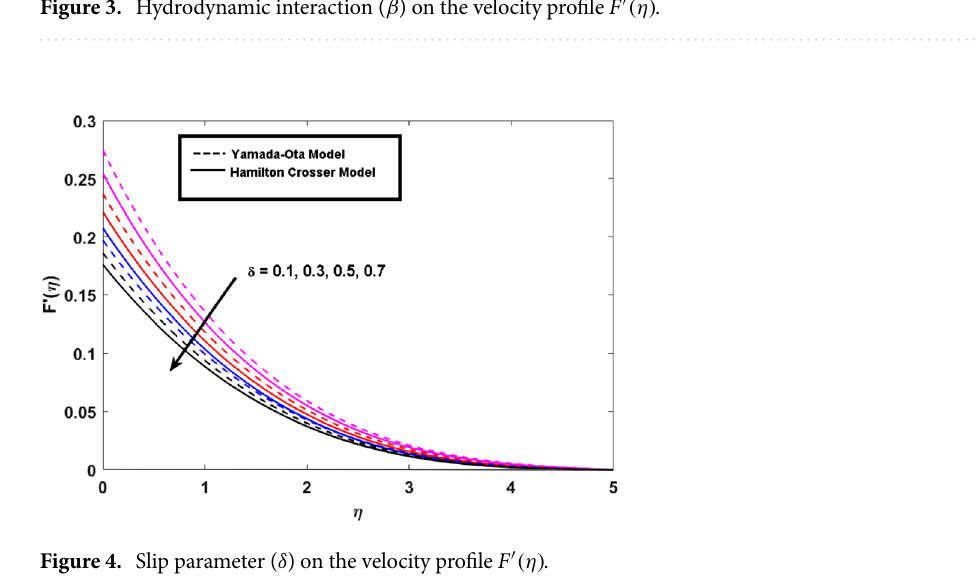
Figure 3. Hydrodynamic interaction ( β ) on the velocity profile F ′ (η) .